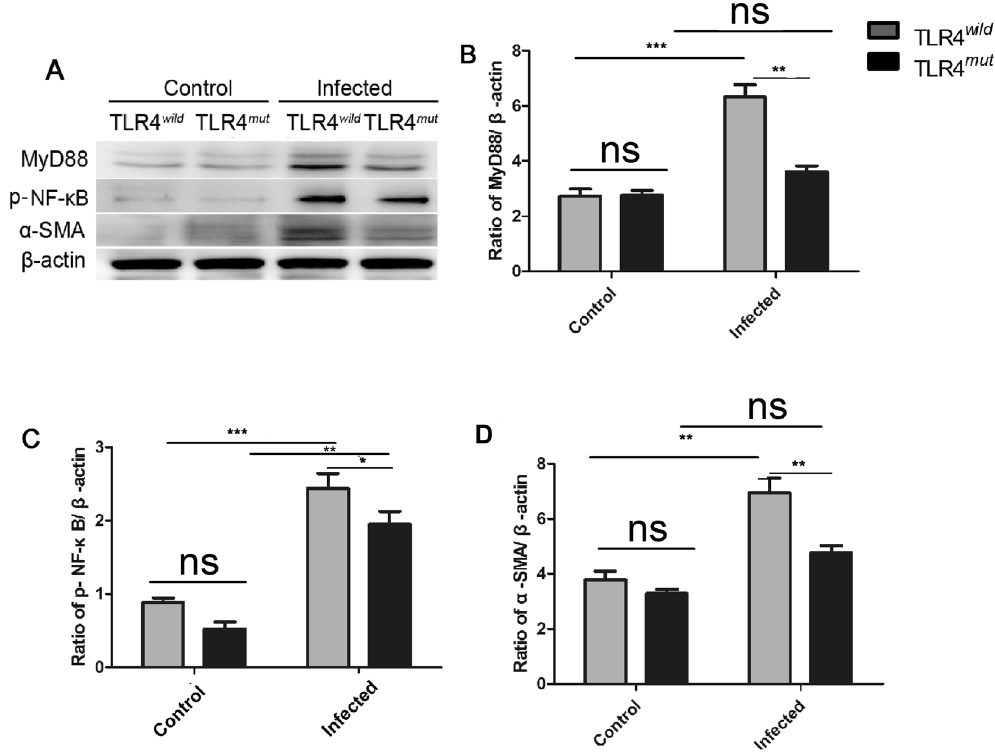
Figure 2. TLR4 signaling pathway is involved in the pathogen-associated biliary fibrosis caused by Clonorchis sinensis . Livers from TLR4 wild and mutated mice infected with or without C . sinensis were harvested, and the sections of tissue containing bile ducts were homogenated or fixed by 4% formalin solution. ( A–D ) Western- blot shows relative expression of MyD88 ( B ), p-NF- κ B ( C ) and α -SMA ( D ) in the liver of healthy normal control and C . sinensis -infected mice with TLR4 wild and TLR4 mut . The blots of each group were run under the same experimental conditions and the images were from the same gel. The data were obtained from 3~5 mice of three-independent experiment. The values were expressed as mean ± SEM. Compared with indicated mice, * P < 0.05, ** P < 0.01, *** P <